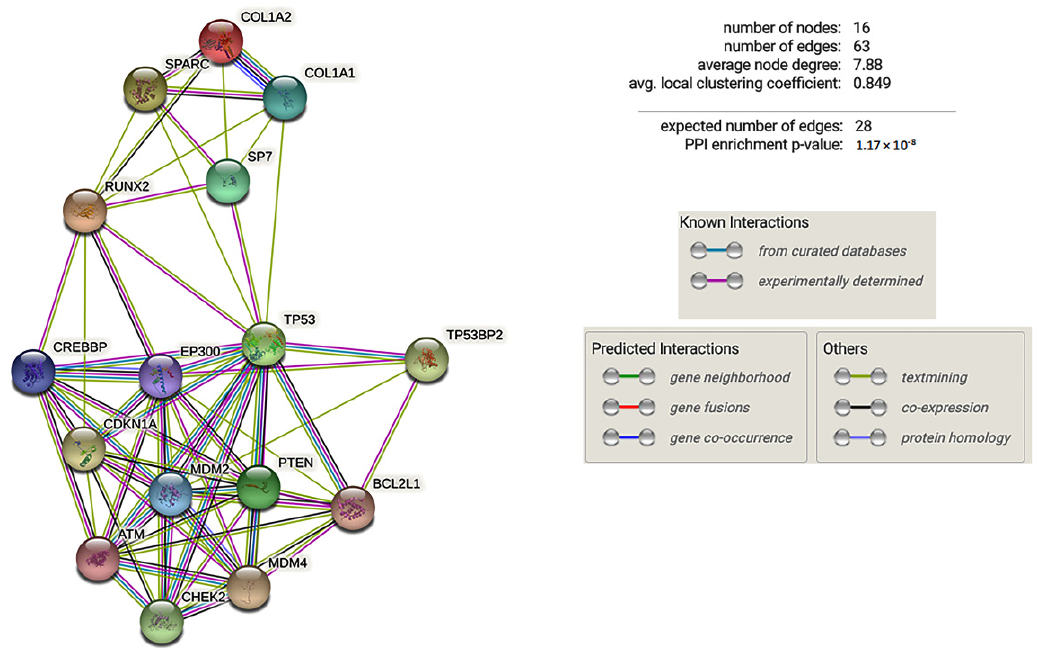
Figure 6. Functional protein interactions identified by the STRING portal. PPI enrichment p -value: 1.17 × 10 − 8 .